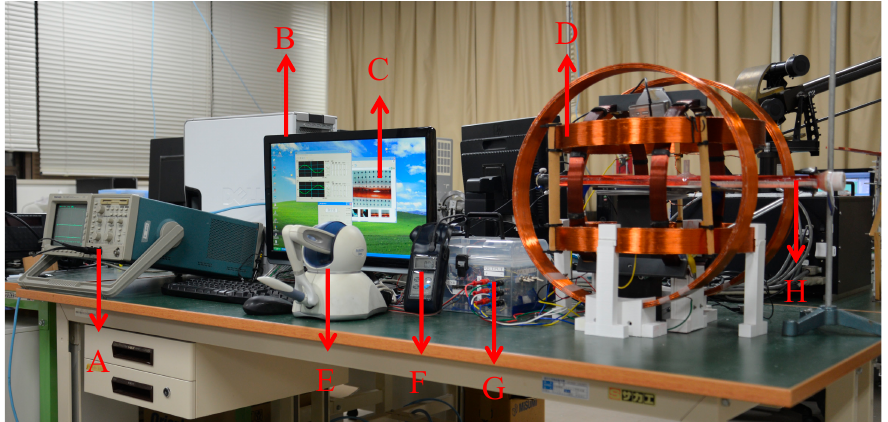
Figure 7. Electromagnetic actuation system. A: Oscilloscope; B: PC; C: Visual images; D: 3-axis Helmholtz coils; E: Phantom Omni device; F: Magnetic sensor; G: Control unit; H: Pipe.